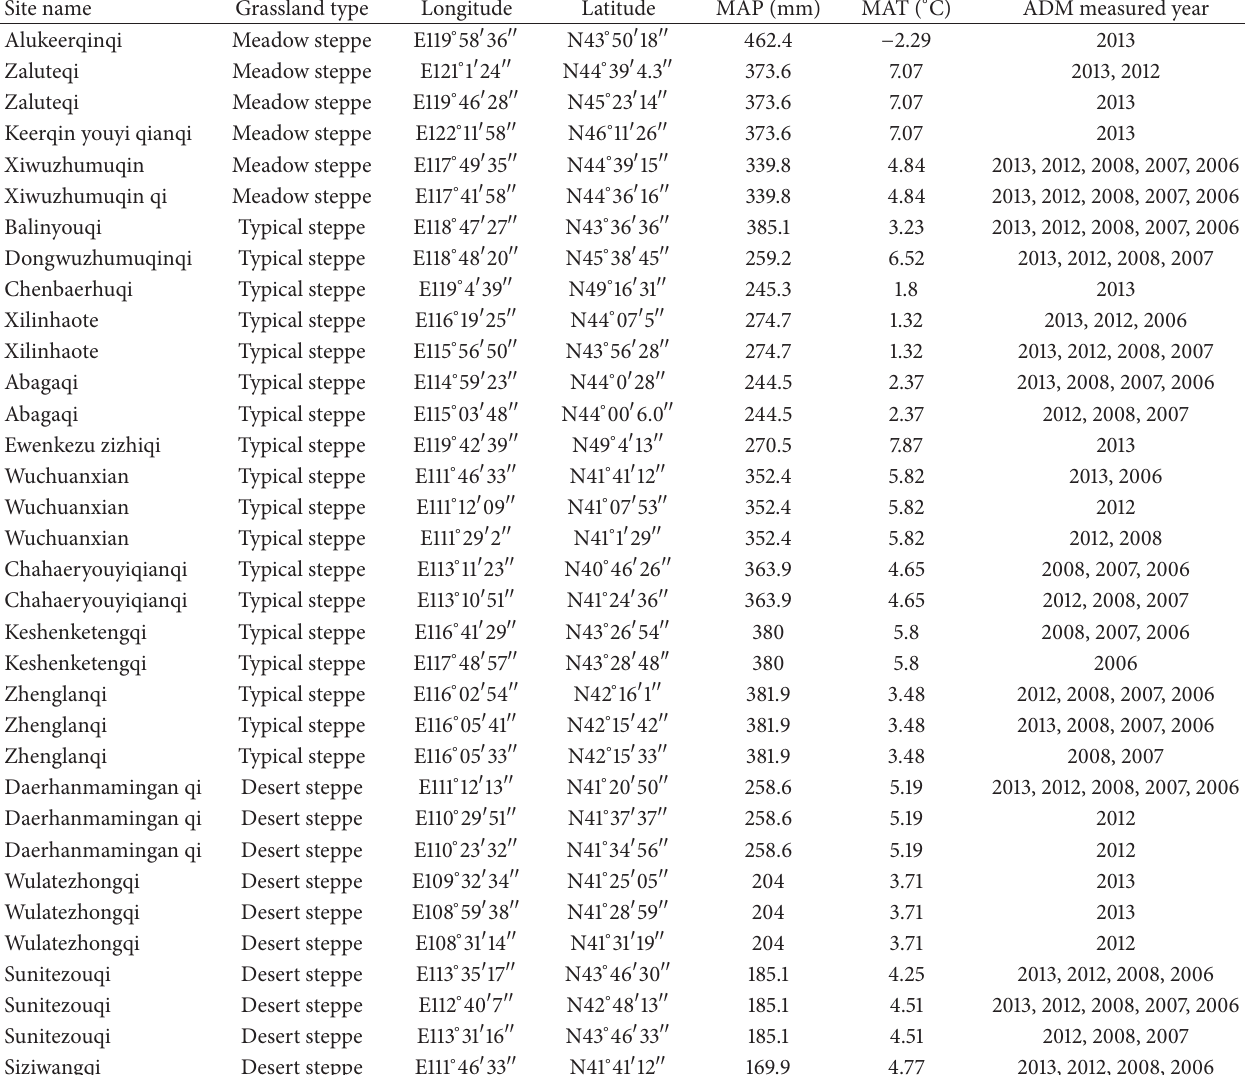
Table 4: Geographical extent, climatic ranges, and above ground dry matter data measured year of sites sampled in Inner